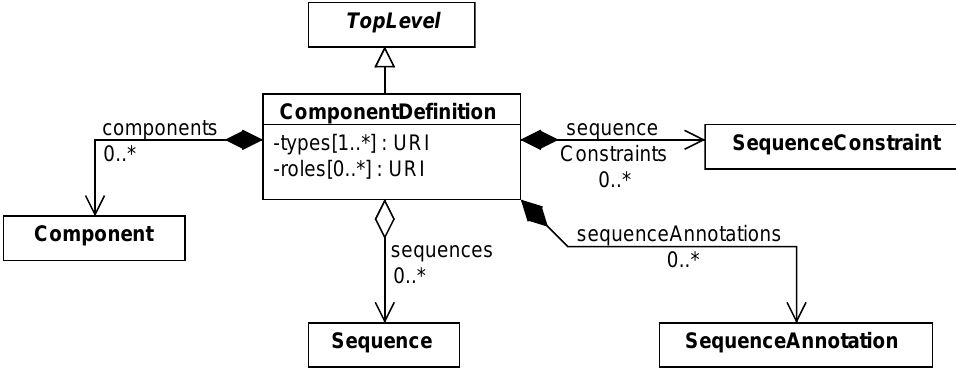
Figure 7: Diagram of the ComponentDefinition class and its associated